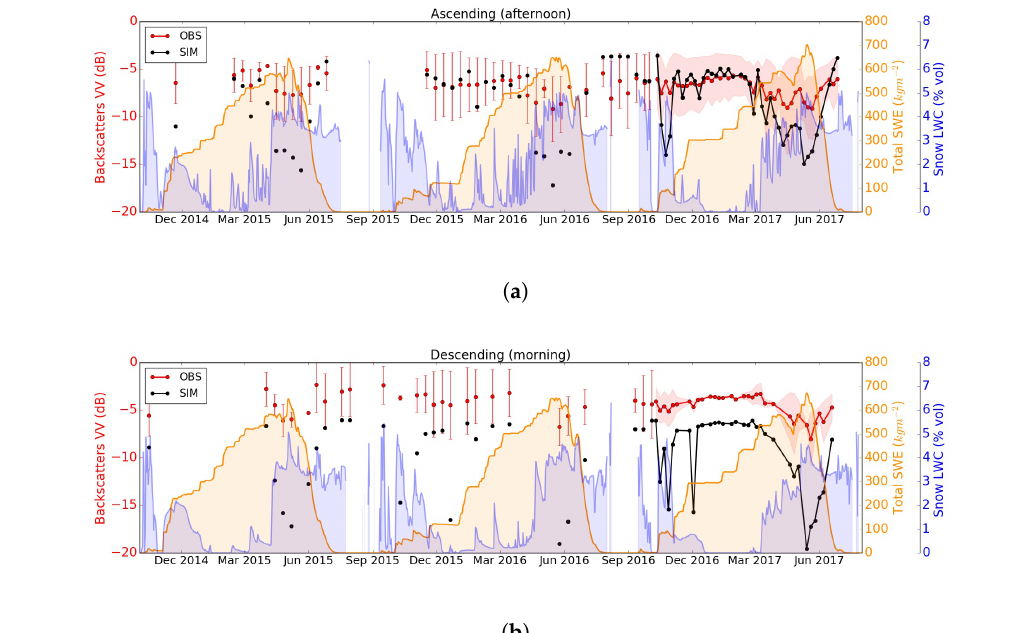
Figure 9. Time series of the backscatter values along the three snow seasons over the whole domain for elevation ranges between 2850 m and 3150 m using all observation scenes available in VV polarization. The domain average mean value of the maximum snow LWC across Crocus snow layers (blue) and the domaine average SWE (orange) are displayed: ( a ) ascending orbit, 1,388,229 pixels; and ( b ) descending orbit, 1,341,956 pixels. Error bars and shading represent one standard deviation around the mean of the observation values, shading being used when the time between two consecutive observations is less than six